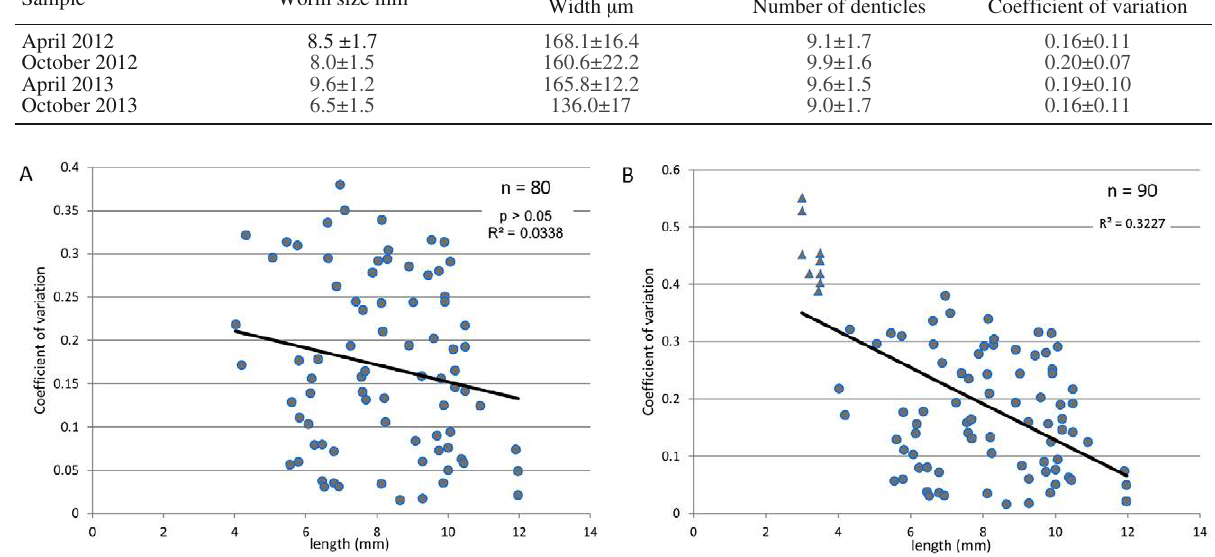
Table 2. – Mean value±standard deviation of the measured body features of Sabellaria spinulosa specimens in the four collecting times Outer paleae Middle paleae Sample Worm size mm Width μm Number of denticles